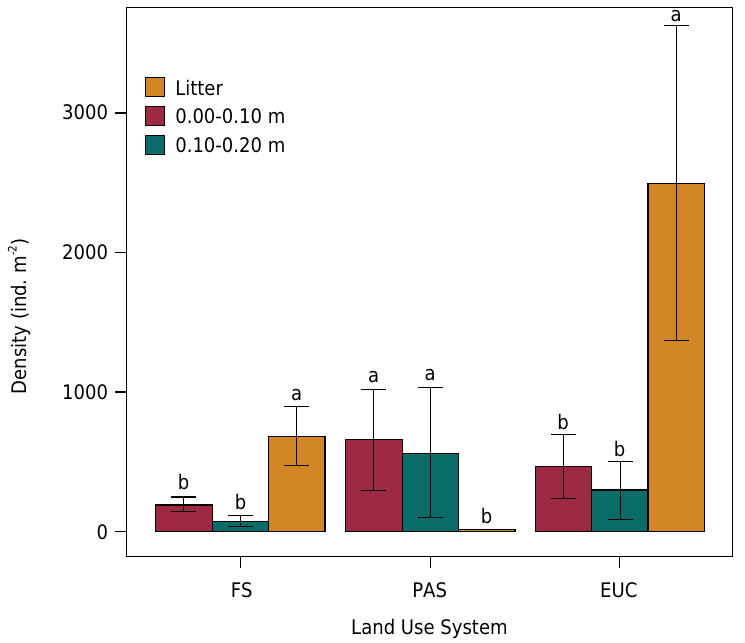
Figure 2. Macrofauna total density (ind. m –2 ) in the different LUS and respective layers in Marabá- PA, Brazil. Mean and standard error (line bars). SF: Secondary Forest; PAS: Pasture; EUC: Eucalyptus. Means followed by the same letters in the same LUS do not have significant difference by Wilcoxon test at 5 % of